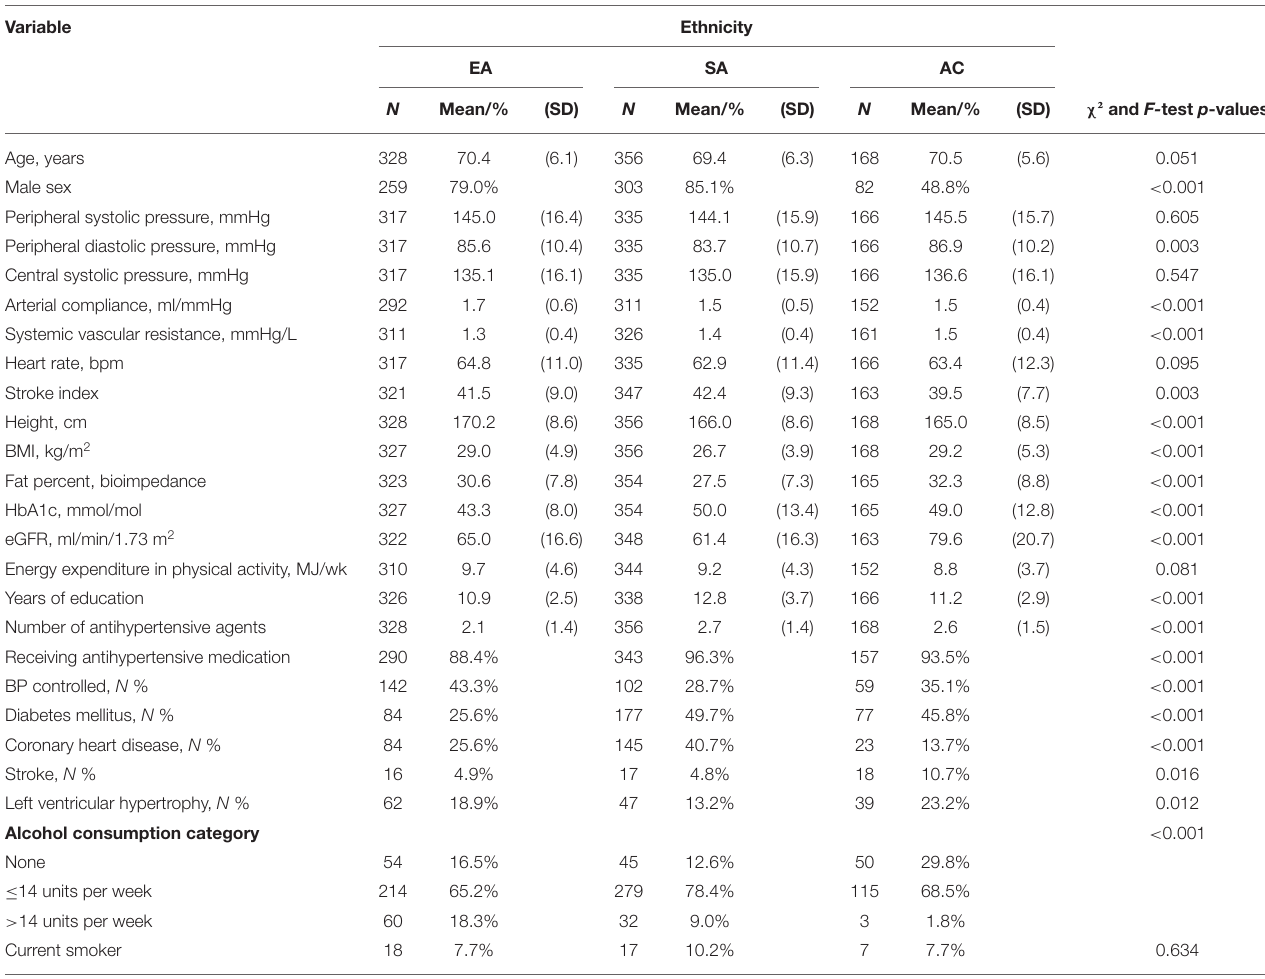
TABLE 1 | Characteristics of participants by